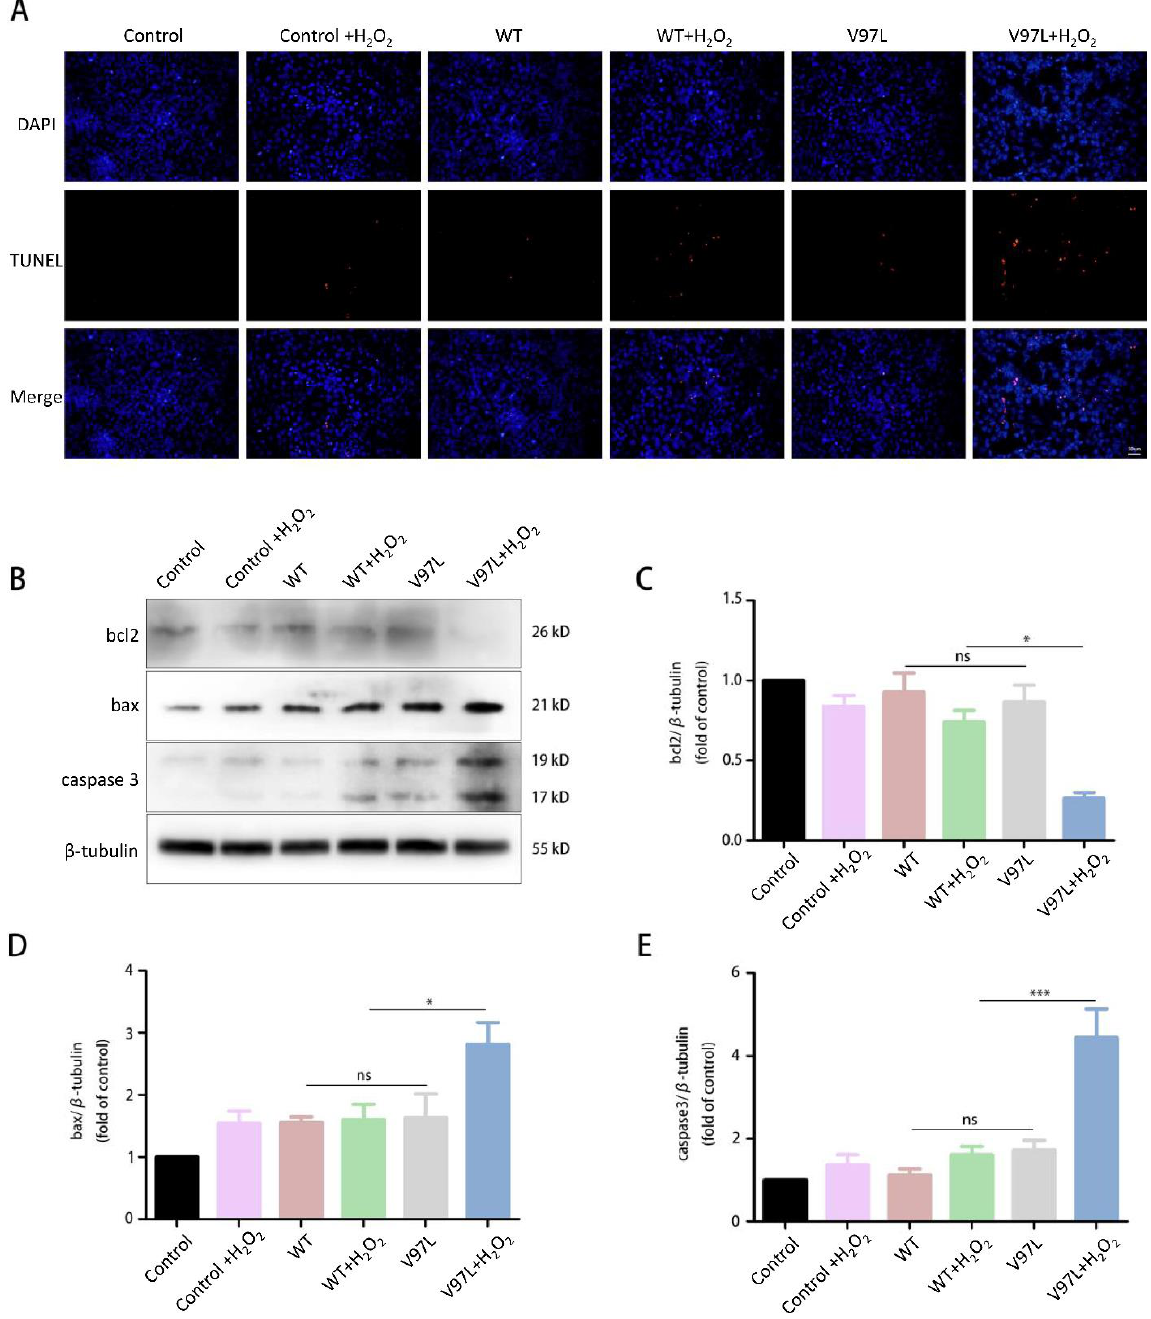
Figure 4. Effects of HSPB1-p.V97L mutation on H 2 O 2 -induced apoptosis in SH-SY5Y cells. Cells were transfected with mutated HSPB1 or wild-type HSPB1 for 48 h followed by H 2 O 2 (300 µM) incubation for 24 h. ( A ) Representative photographs of fluorescent staining for DAPI (blue) and TUNEL (red). ( B ) Representative bands of western blot. ( C , D , E ) Quantitative analysis of the western blot bands. Control = SH-SY5Y cells. Data are presented as the means ± SEM of three independent experiments. ns, no significance, * p < 0.05; *** p < 0.001. Scale bar = 50 µm.